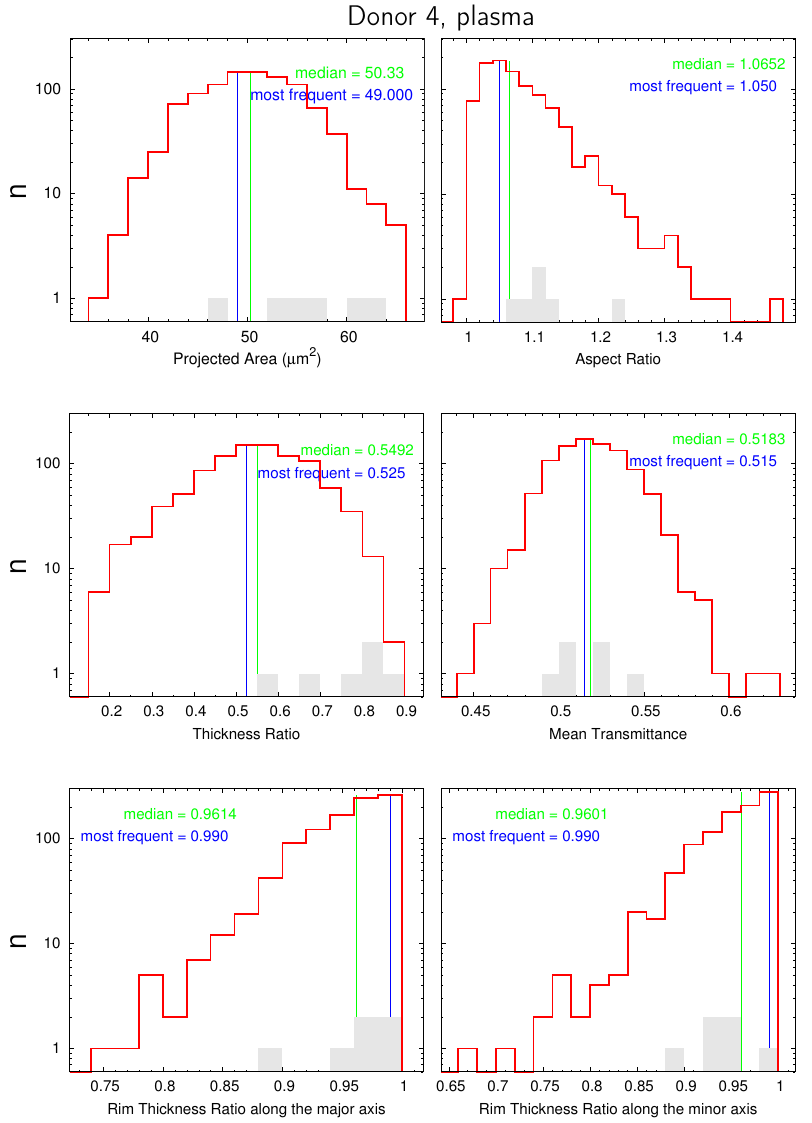
Figure 7. Example of the first page of the data sheets of donor 4. The histogram of normal cells is shown in red. The gray columns indicate the distribution of the E1s found for the respective donor. Blue lines indicate the middle of the most frequent bin. Green lines indicate the exact median value of the respective, red